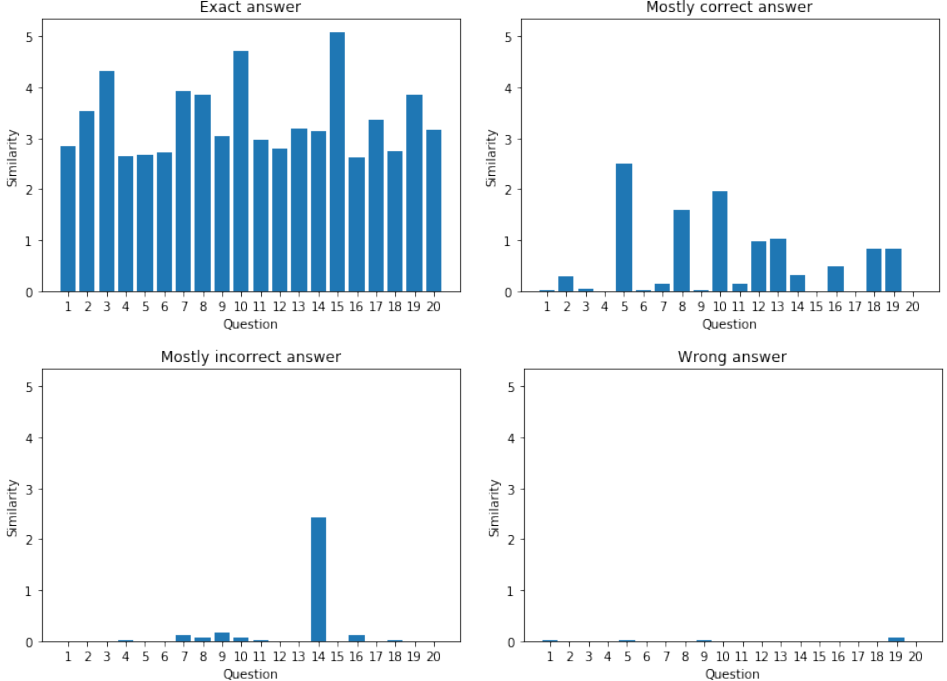
Figure 11. Results of word matching implementation.